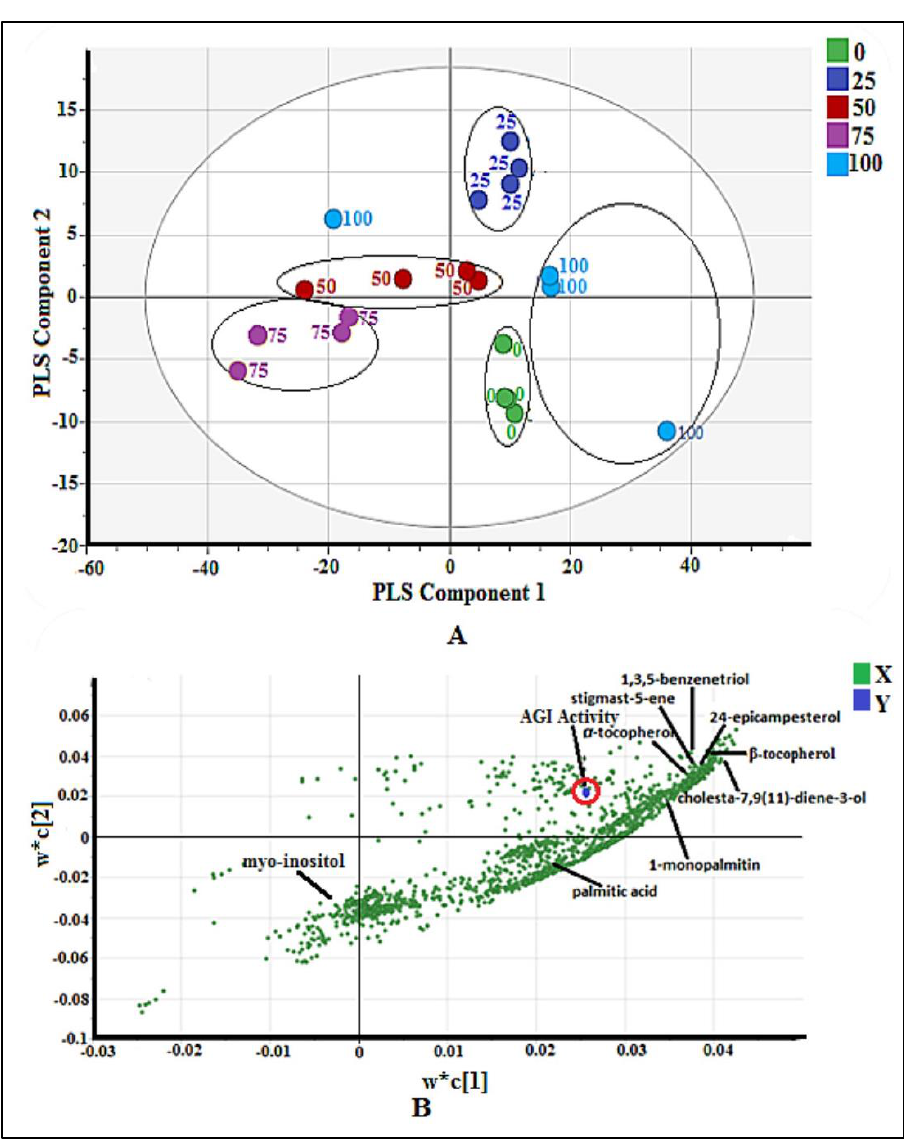
Figure 2. ( A ) Score scatter plot of validated PLS model for 20 extracts of P. malayana leaves ( n = 4), indicates the clear separation among the five groups (0, 25, 50, 75, and 100% v / v methanol-water). ( B ) The loading scatter plot of PLS model, indicates the correlation between the AGI activity (Y variables) and the samples’ m / z value (X variables).